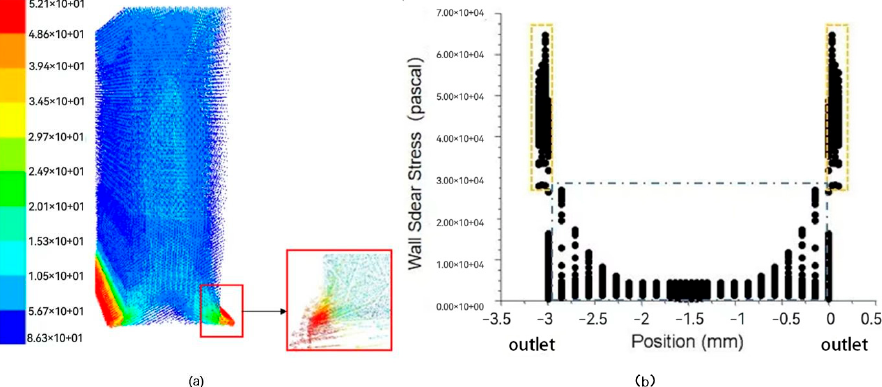
Figure 5. Particle velocity vector diagram of flow field in screen ( a ) and a scatter diagram of wall shear force along Z axis of screen ( b ).